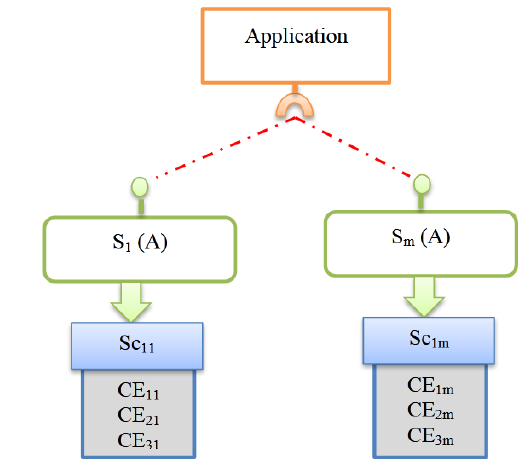
Figure 7 . Service with its versions